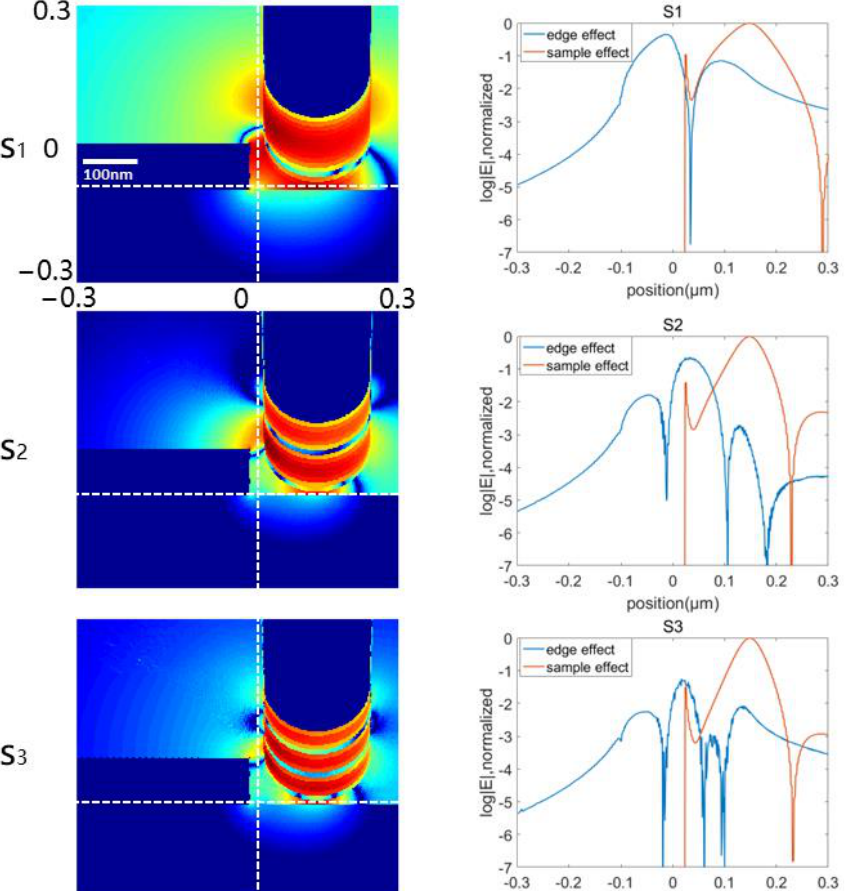
Figure 9. The near-field electric field image of the edge effect at harmonic signal (S 1 , S 2 , S 3 ) and electric field intensity comparison curves.